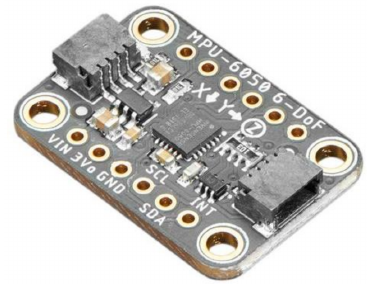
Figure 18. Adafruit MPU-6050 (Breakout Board).